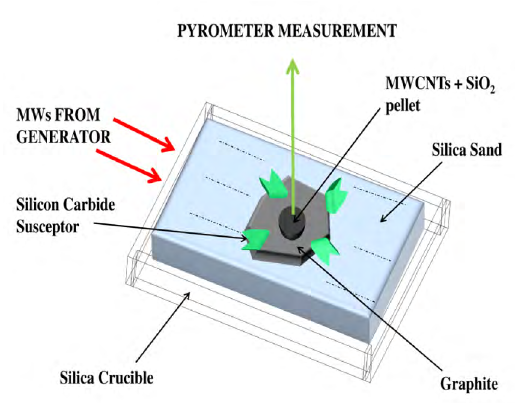
Figure 1. Schematic diagram of setup inside microwave